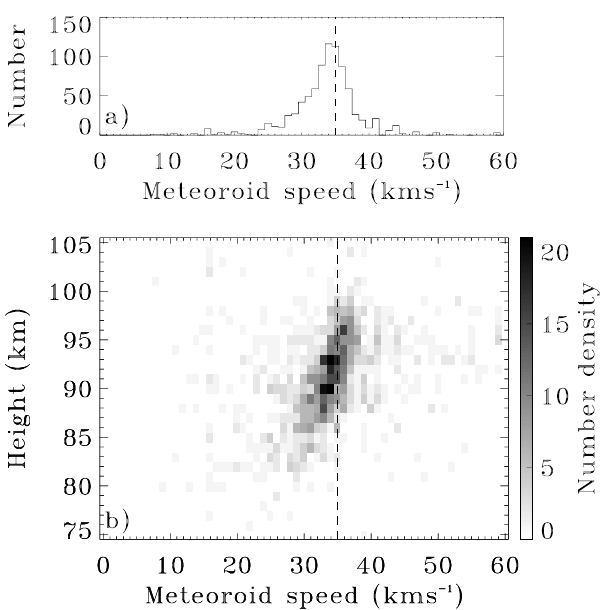
Fig. 10. Results of the application of Fresnel transform speed es- timation to meteor echoes identified as Geminid shower meteors using the radiant mapping procedure for data collected by the Dar- win meteor radar on 15 December 2005: (a) speed distribution, (b) speed versus height distribution. The dashed line indicates the the- oretical pre-atmospheric entrance speed of Geminid shower mete- oroids (35kms − 1 ).